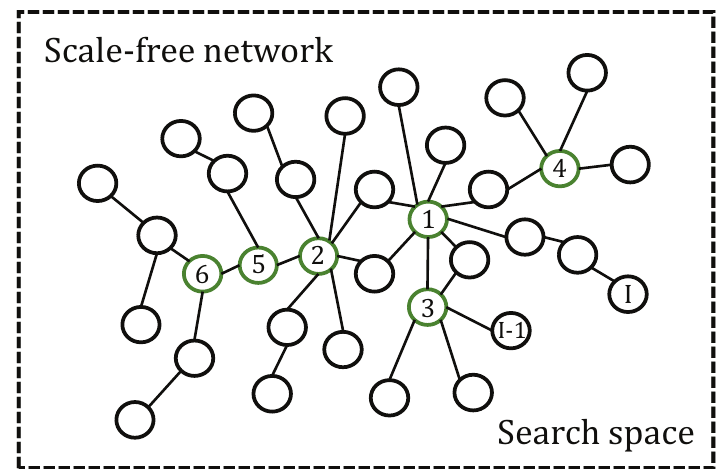
Figure 2. Topology of the scale-free network in the search